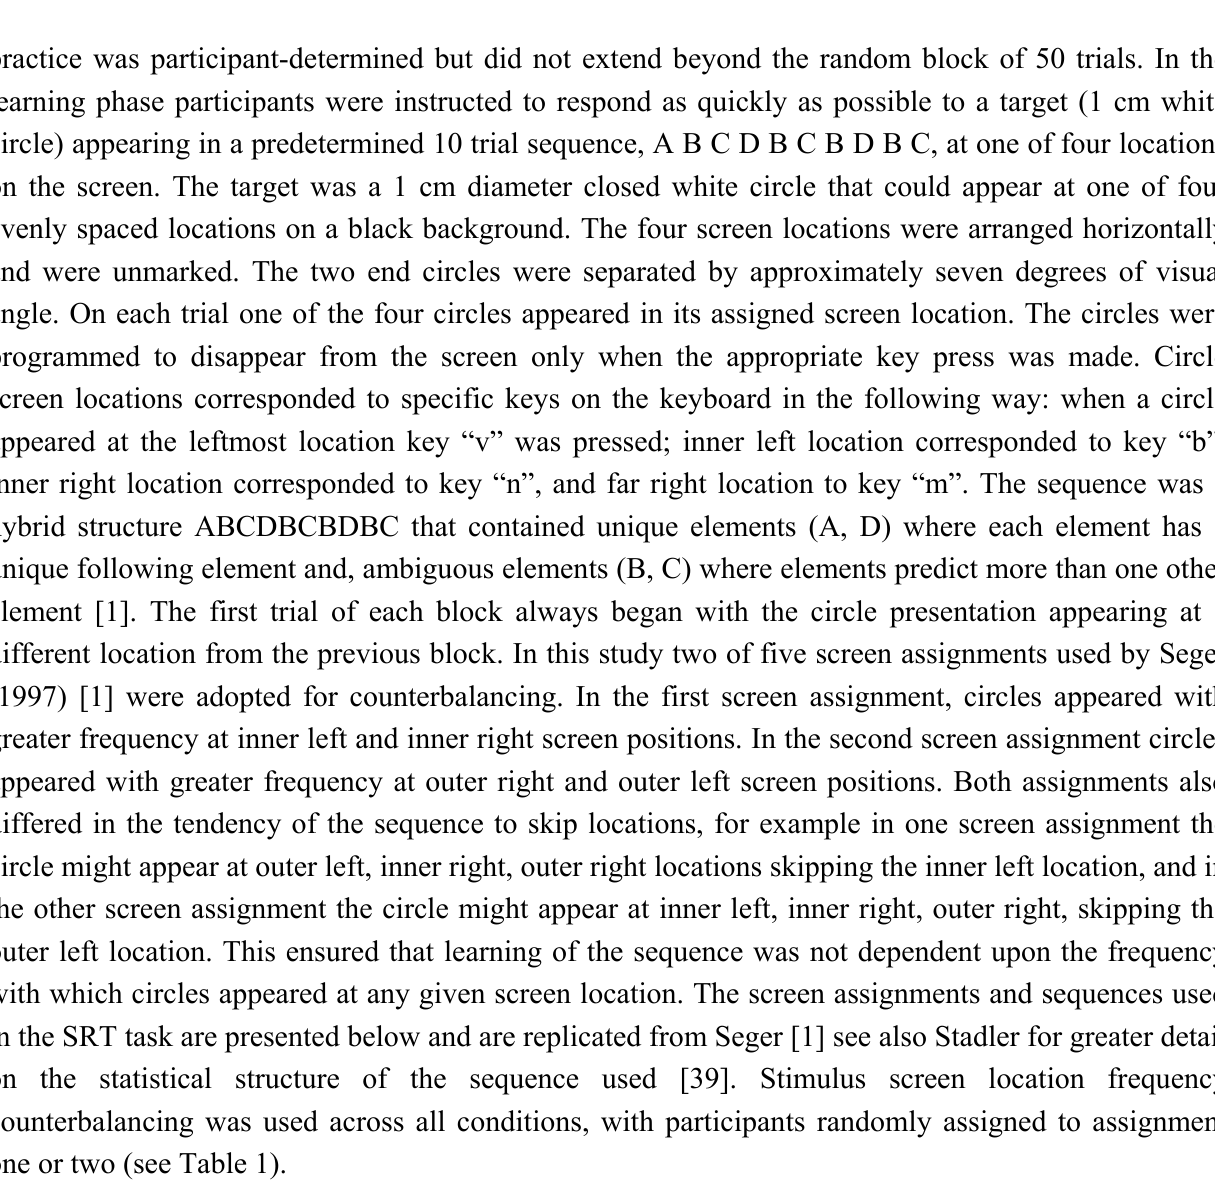
Table 1. Counterbalancing of screen locations for the SRT